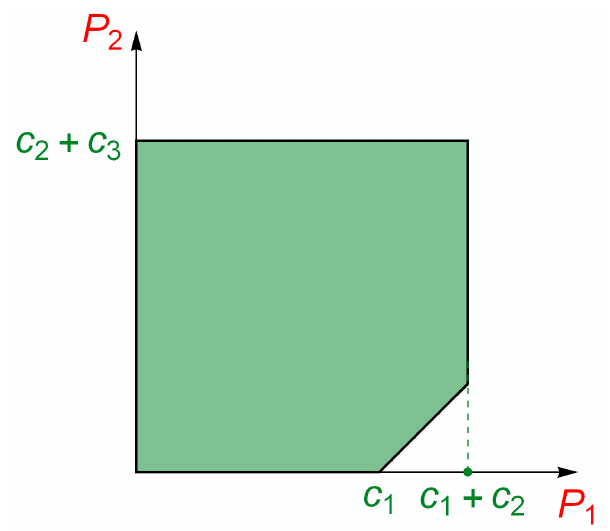
Figure 9 . The positive region for the wave equation with two points on the past